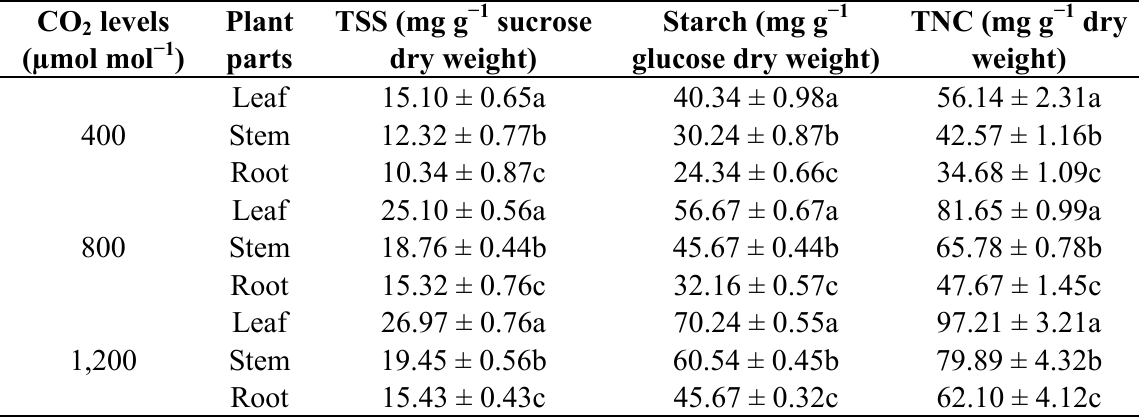
Table 3. Accumulation and partitioning of total soluble sugar (TSS), starch and total non structurable carbohydrate (TNC) in different plant parts of Labisia pumila Blume. under different CO 2